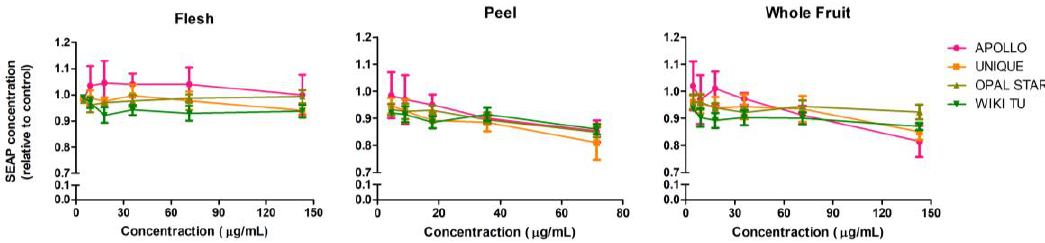
Figure 2. Anti-inflammatory activity on the HEK-Blue™ hTLR4 cell line. Cells were treated with feijoa flesh, peel and whole fruit extracts from APOLLO, UNIQUE, OPAL STAR and WIKI TU cultivars. Lipopolysaccharide (LPS) ligand was used to stimulate an inflammatory response through the TLR4 pathway. The SEAP concentration was normalized against the solvent control. A low SEAP concentration indicates a strong anti-inflammatory effect.